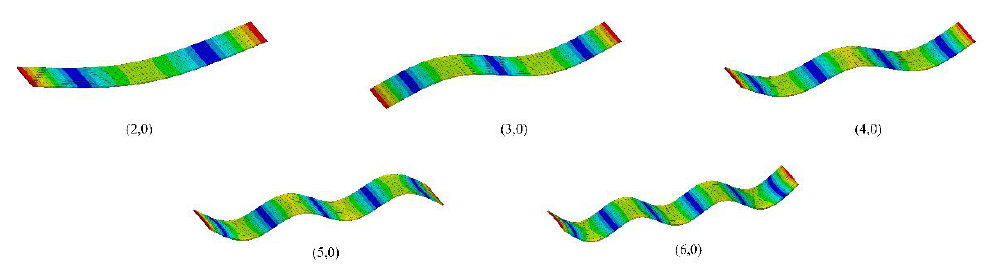
Figure 8. Modes obtained through experimentation, following the nomenclature (m,n) [32] .